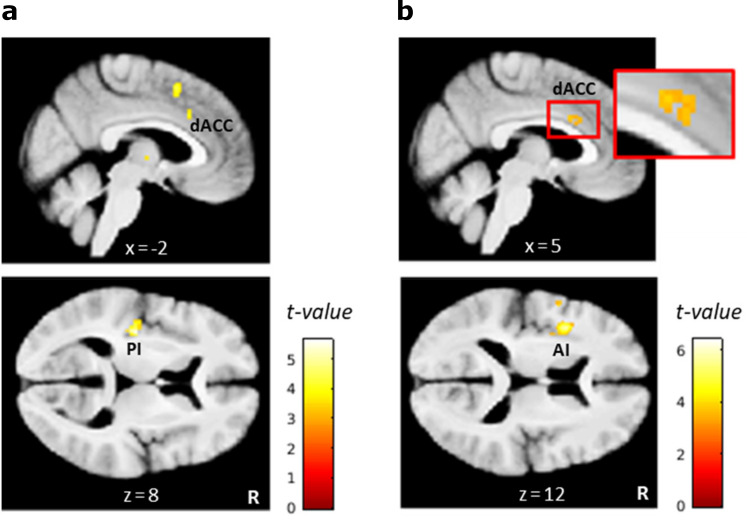
L-dopa effects on neural coding of overall uncertainty.(a) Regions in which activity correlated positively with the overall uncertainty in the placebo condition included the dorsal anterior cingulate cortex (dACC) and left posterior insula (PI). (b) Regions in which the correlation with overall uncertainty was reduced under L-dopa compared to placebo included the dACC and left anterior insula (AI). Thresholded at p<0.001, uncorrected. R: right.